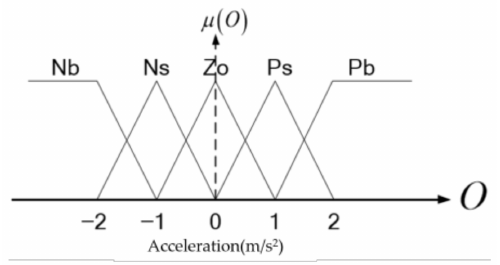
Figure 14. Membership functions for characterizing control command.